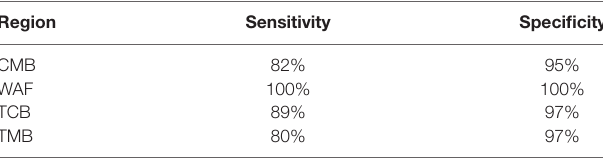
TABle 2 | Sensitivity and specificity of the 33–single-nucleotide polymorphism barcode in tracing the origins of the isolates from four regions.